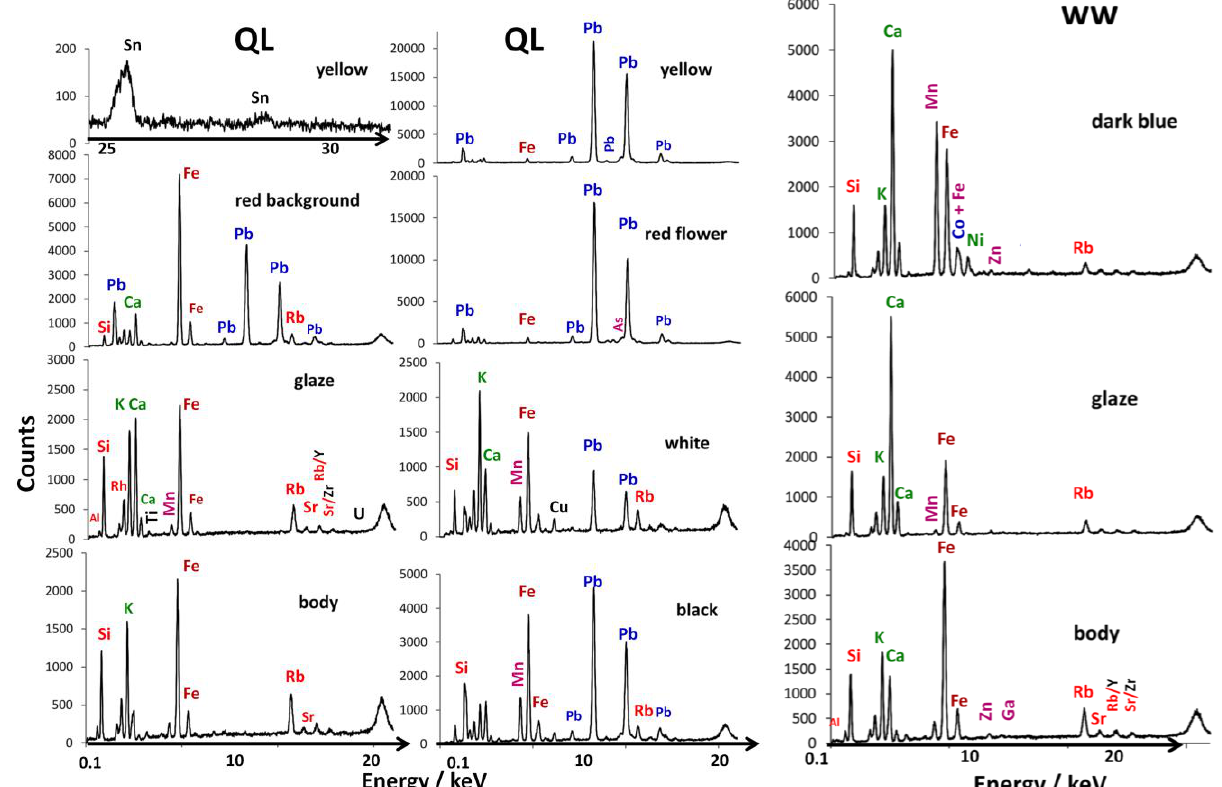
Figure 4. Left and center, representative pXRF spectra recorded on the body section, the colorless glaze (surface), the red background and the different colored overglazes of the imperial bowl excavated fragment (QL, Figure 1a). Right, representative pXRF spectra recorded on the body section, the colorless glaze (surface) and the blue area of the blue and white cut fragment (Figure 1b, ww).